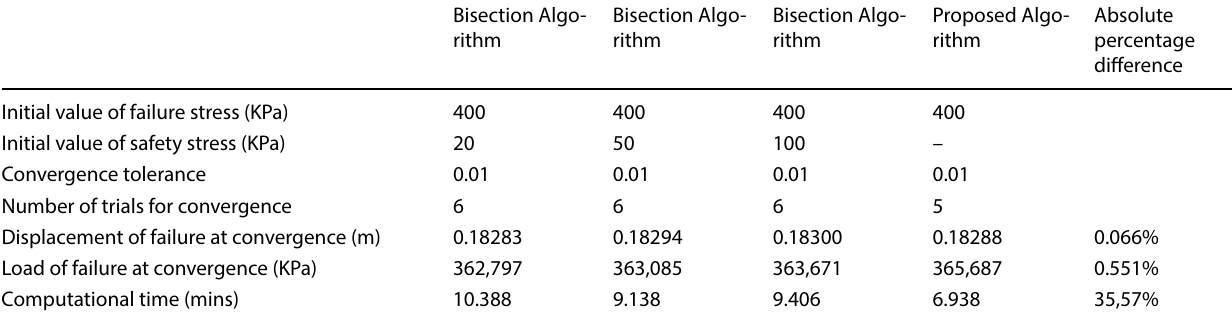
Table 1 Comparison of the proposed algorithm with the bisection method for the calculation of the failure load 𝜆 ∗ and failure displacement